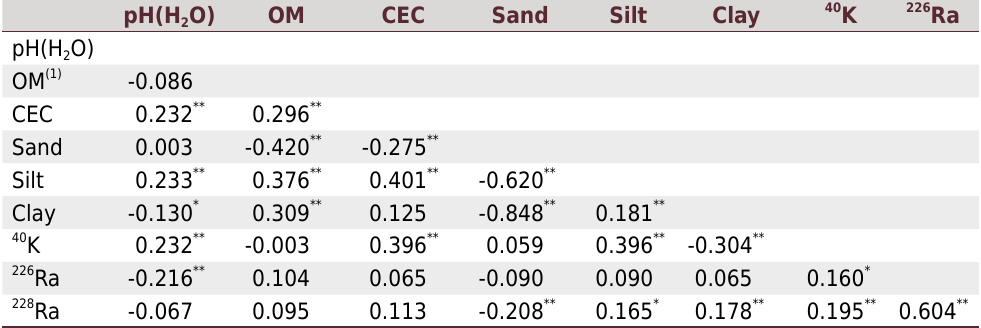
Table 7. Matrix of Spearman’s correlation between the soil properties and the studied